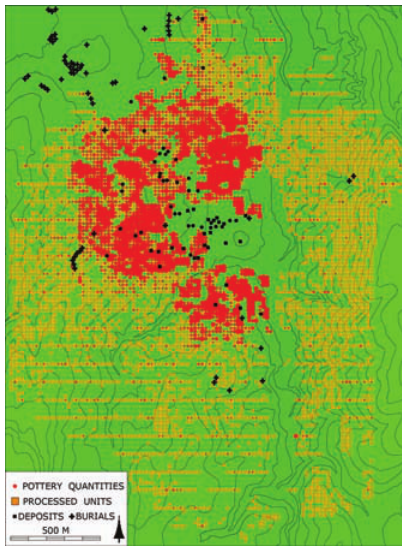
Figure 8 Hellenic evidence, excavations and surface pottery counts.